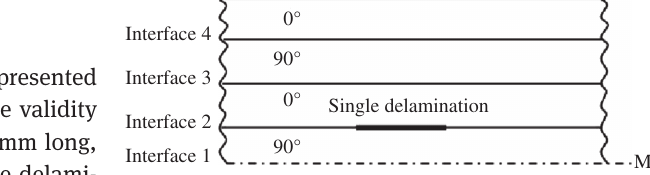
Figure 5 Typical interface locations of the delamination for a graphite/epoxy composite [0/90] 2s